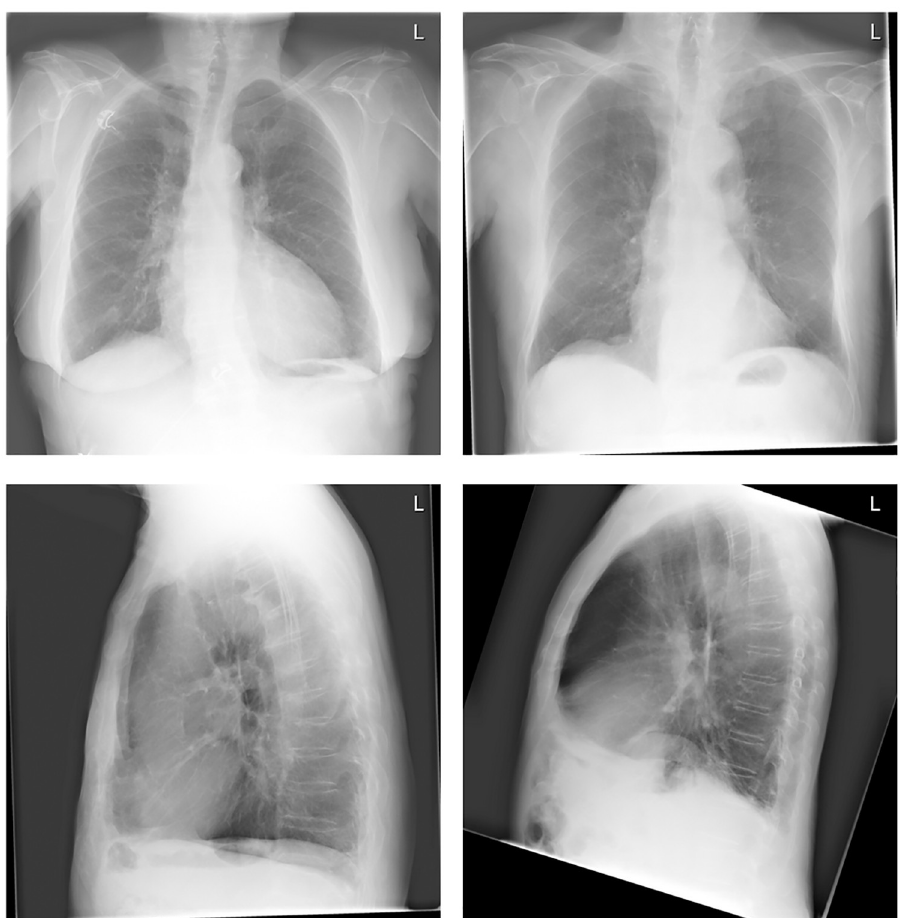
Fig 1. The 4 radiological signs. The top row shows the radiological signs on frontal chest radiographs. The left frontal chest radiograph shows the flattening of the diaphragm, and the right shows irregular radiolucency. The bottom two chest radiographs show the radiological signs on the lateral chest radiograph. The left lateral chest radiograph clearly shows the flattening of the diaphragmatic contours while the right demonstrates an abnormal retrosternal space.